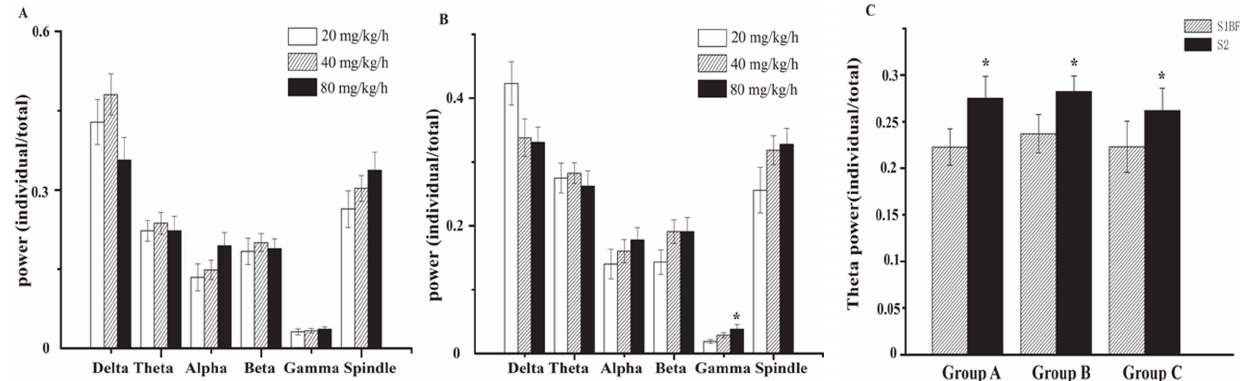
Figure 3. The changes of EEG power: Delta (1–4 Hz), Theta (4–8 Hz), Alpha (8–12 Hz), Bata (12–25 Hz) and Gamma band(25–100 Hz) as well as Spindle wave(7–14 Hz) in S1BF and S2 when the rats were infused with propofol infused at 20, 40 and 80 mg/kg/h. A) EEG power in S1BF at different dosage of propofol and no difference among the three groups(infusion rates); B) EEG power in S2 at different dosages of propofol and no difference among the three groups except the delta power in propofol 80 mg/kg/h was stronger than that in propofol 20 mg/kg/h; C) The change of theta power under different dosages of propofol. The power of h wave in S2 was larger than that in S1BF In any group A,B and C *p , 0.05.